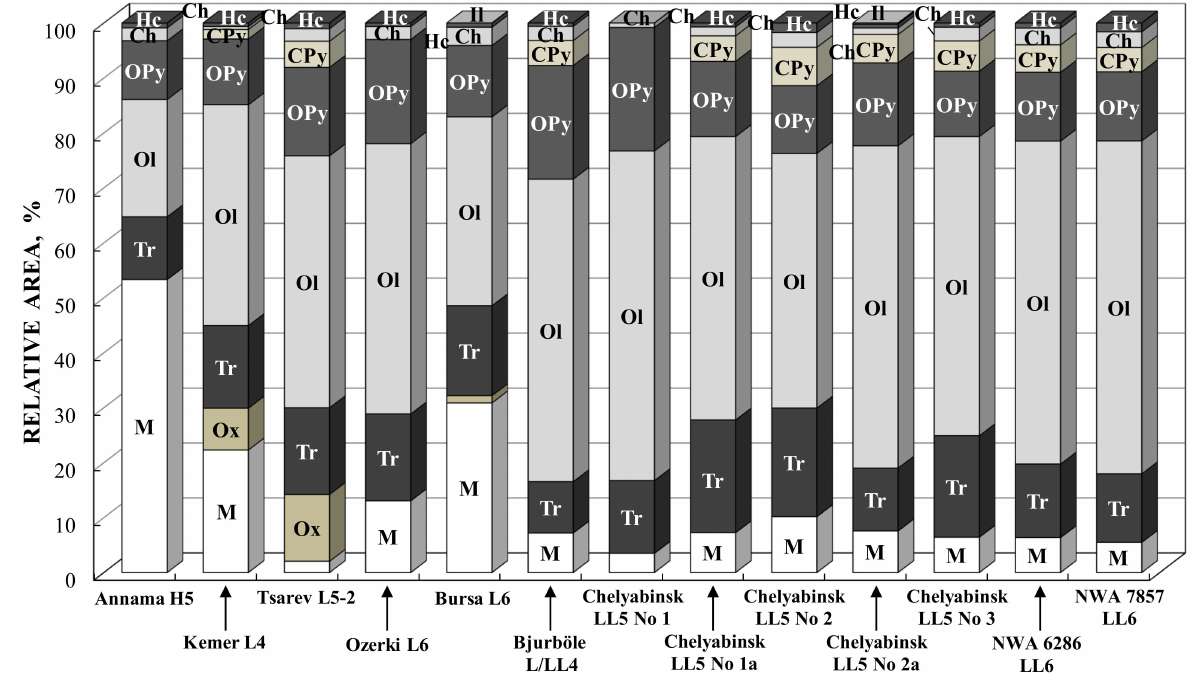
Figure 39. Modal analysis of the phase composition (the relative iron fractions) using the total relative areas of components revealed in the Mössbauer spectra of equilibrated H, L, and LL ordinary chondrites measured with a high velocity resolution. (cid:3) —the α α -Fe(Ni, Co) + γ -Fe(Ni, Co) phases ( M ), —ferric compounds ( Ox ), (cid:4) —troilite + Fe 2 -Fe(Ni, Co) +